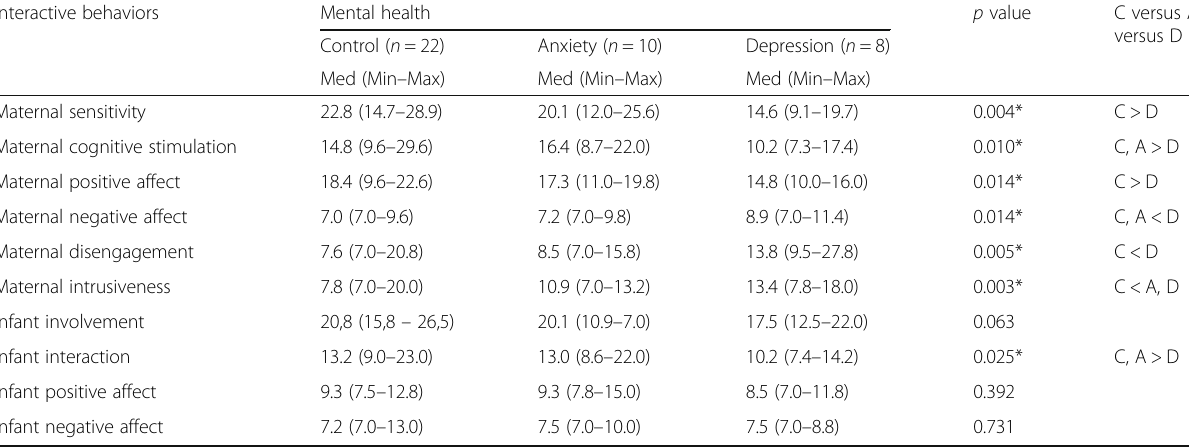
Table 3 Comparison of infant and maternal interactive behaviors in the three groups: control, chronic anxiety and depression Interactive